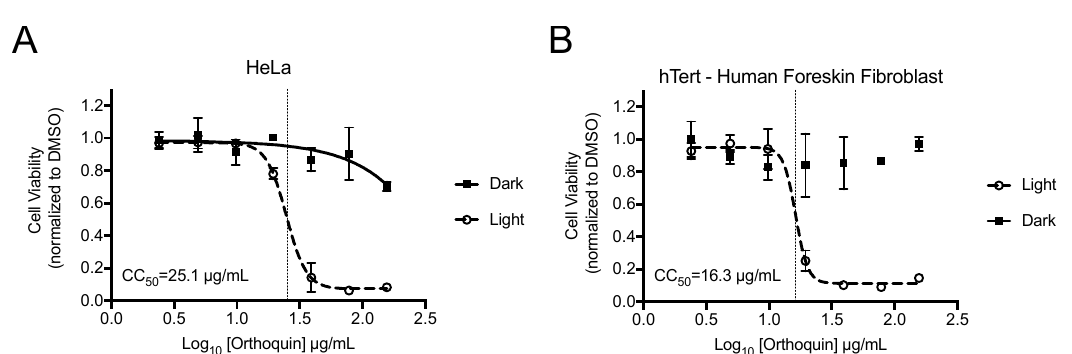
Figure 2. Establishment of phototoxic threshold of Orthoquin on HeLa ( A ) and hTert-immortalized human BJ cells ( B ). Cells were seeded in a 96-well plate and treated the following day with Orthoquin or DMSO vehicle control. At 16 h post-treatment, plates were exposed to a visible LED light for 30 min, with the dark plate wrapped in aluminum foil. alamarBlue ® cell viability assay was performed 48 h post-treatment. n = 3 ± SEM independent biological replicates. CC 50 values, denoted with a vertical line, were calculated using Prism 7.